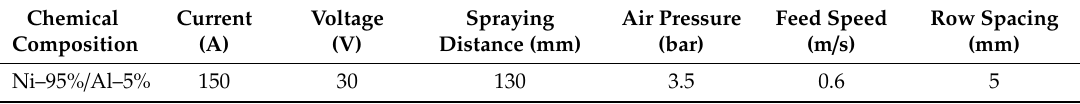
Table 4. Feedstock material and parameters used for the thermal spraying